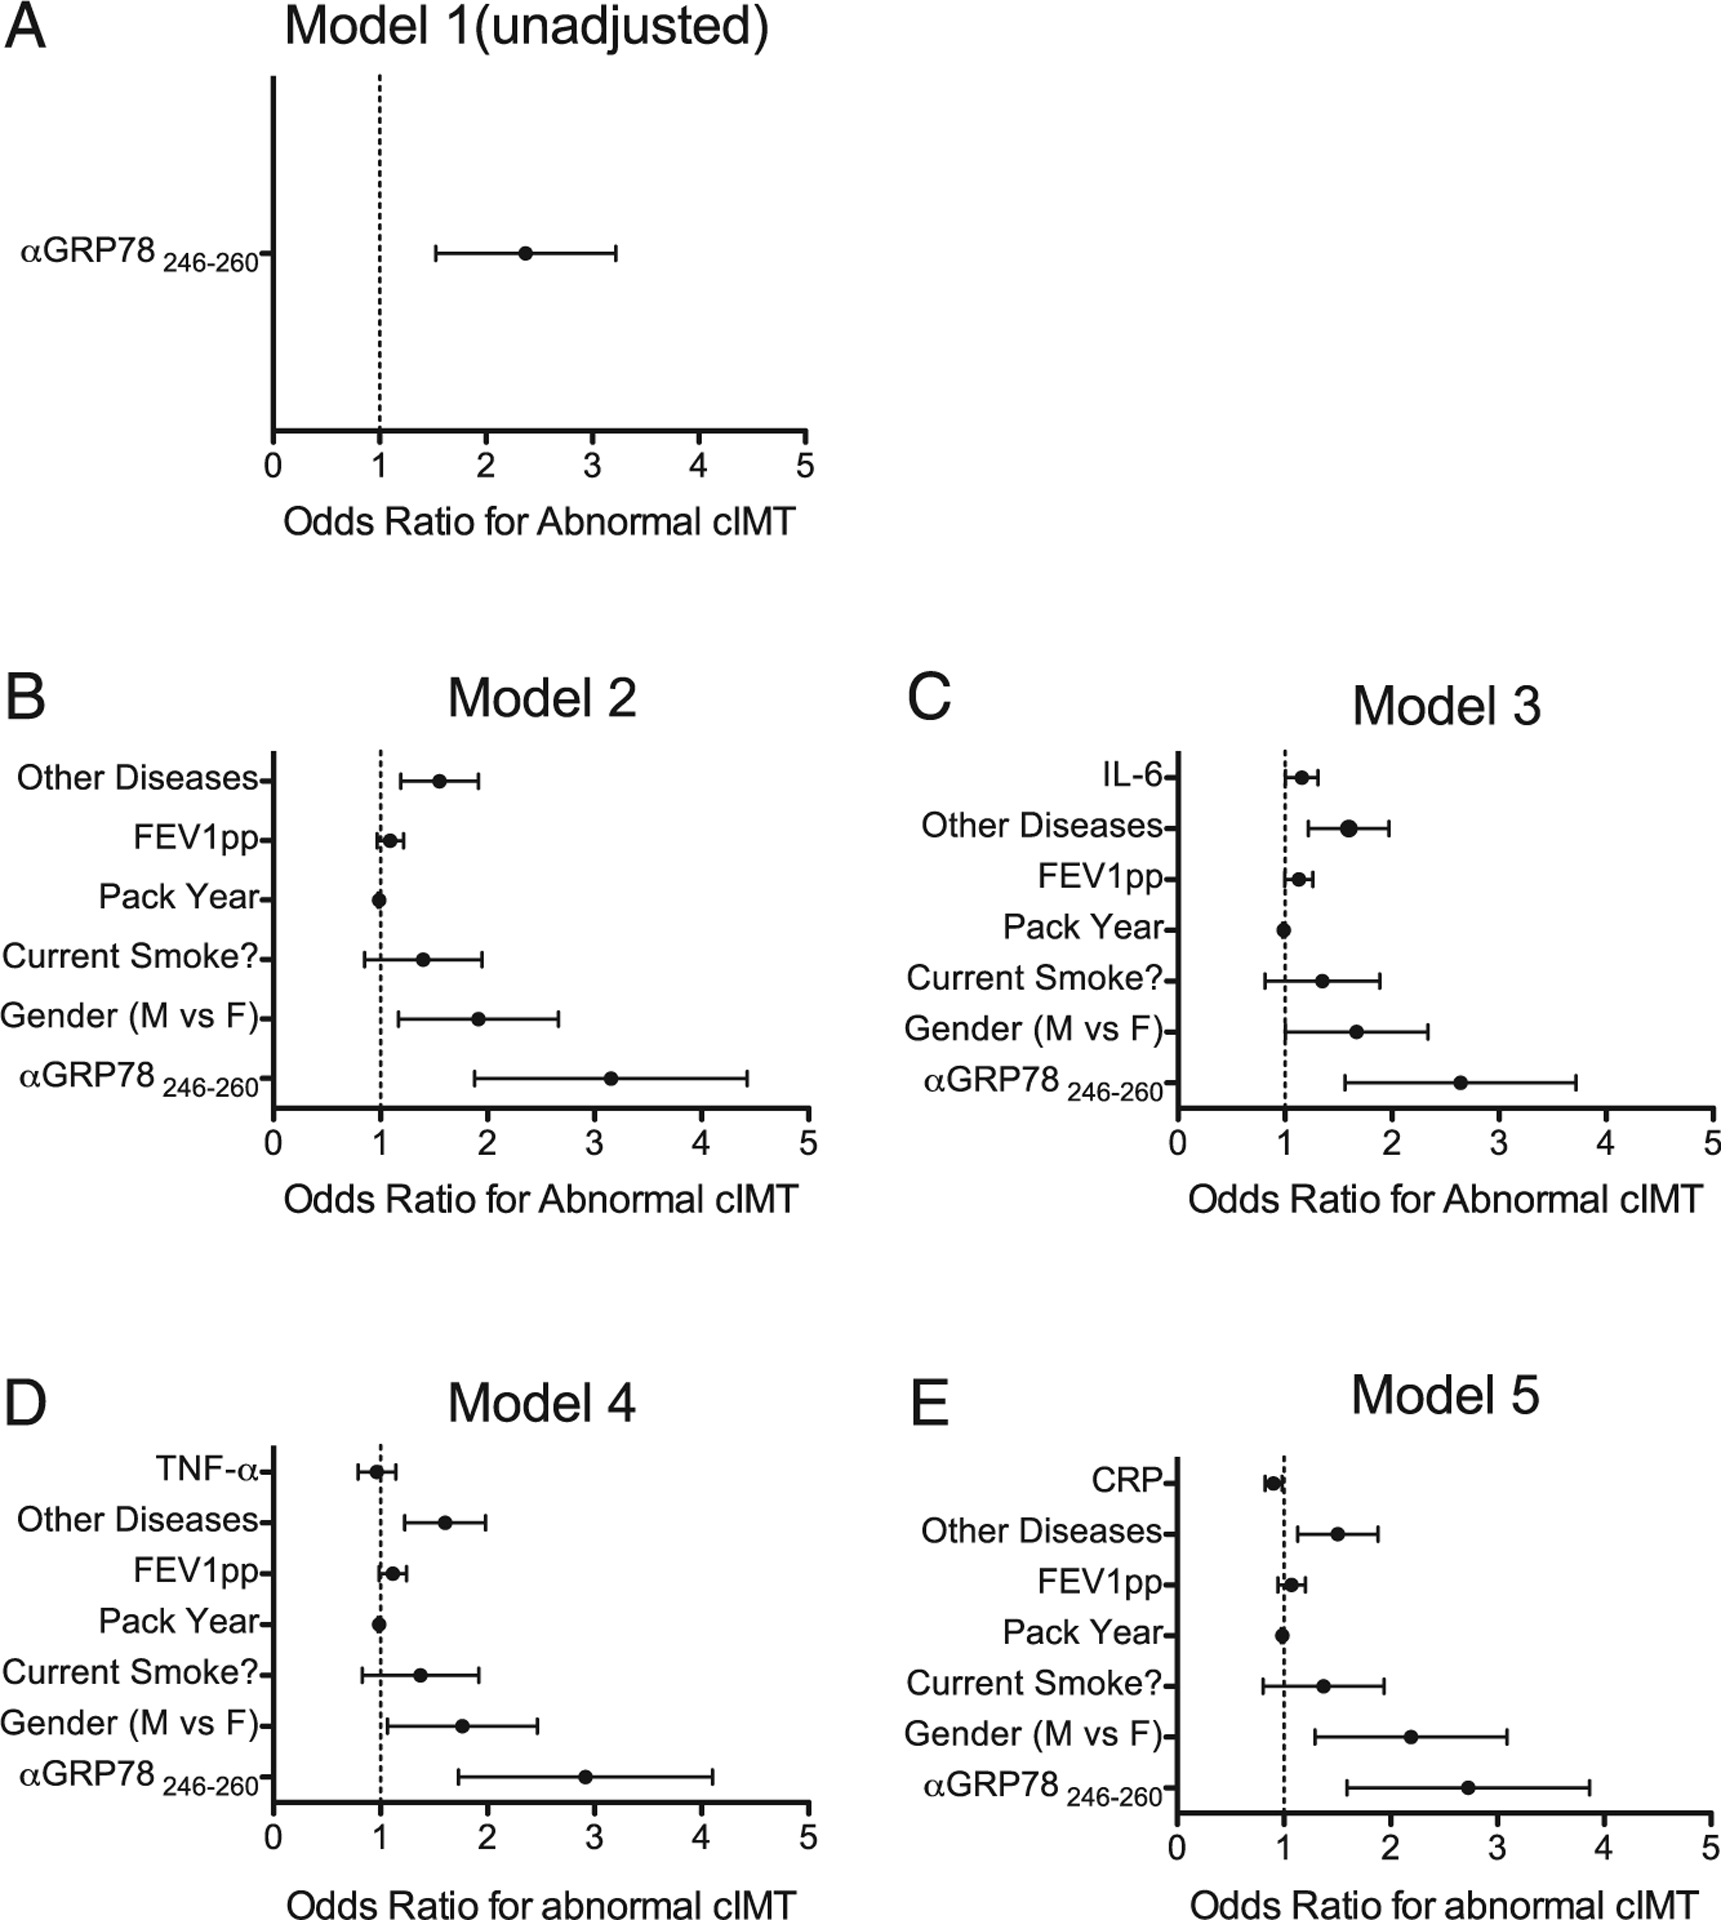
Logistic models to predict the relationships of anti-GRP78aa 246–260 autoantibodies with the presence of abnormal cIMT (≥0.9 mm).(A) Unadjusted model shows the OR of having an abnormal cIMT per an increase in 0.1 OD of anti-GRP78aa 246–260 autoantibodies. (B) Model 2 has been adjusted by gender, current smoking status, pack years, FEV1pp, and the presence of other chronic diseases associated with atherosclerosis (hypertension, diabetes, and hyperlipidemia). (C) Model 3 has been adjusted to include all the variables in model 2, plus the addition of circulating IL-6 (picograms per milliliter). (D) Model 4 has been adjusted to all the variables in model 2, with the addition of TNF-a (picograms per milliliter). (E) Model 5 has been adjusted to all the variables in model 2, with the addition of hs-CRP level (micrograms per milliliter). Bars denote 95% CI.